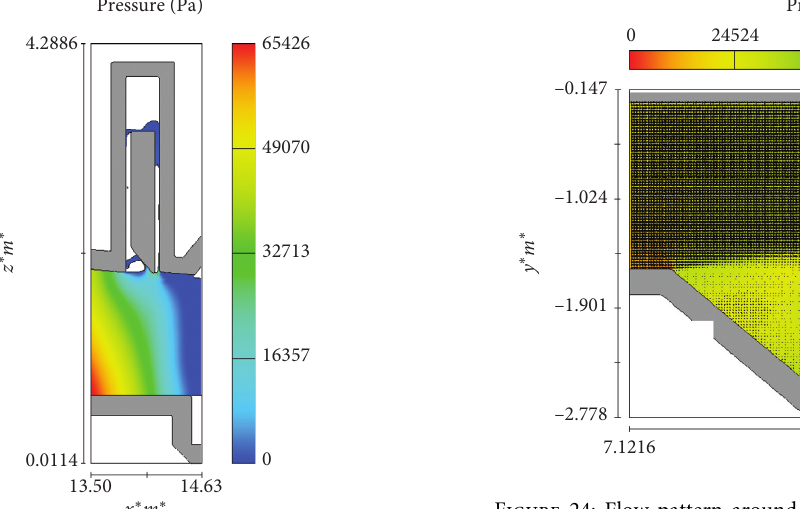
Figure 22: Pressure distribution under the gate for 100% opening mode (100% valve opening).